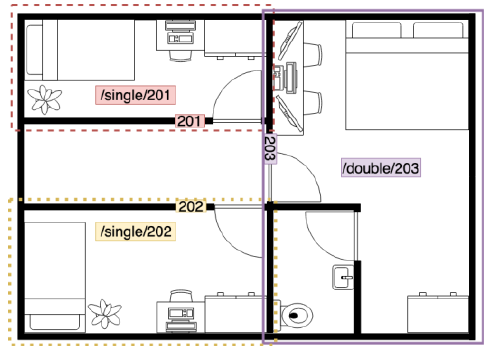
Figure 17. The example of room topic in smart hotel.